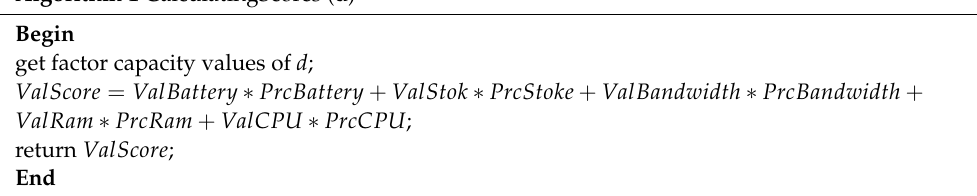
Algorithm 1 CalculatingScores (d)